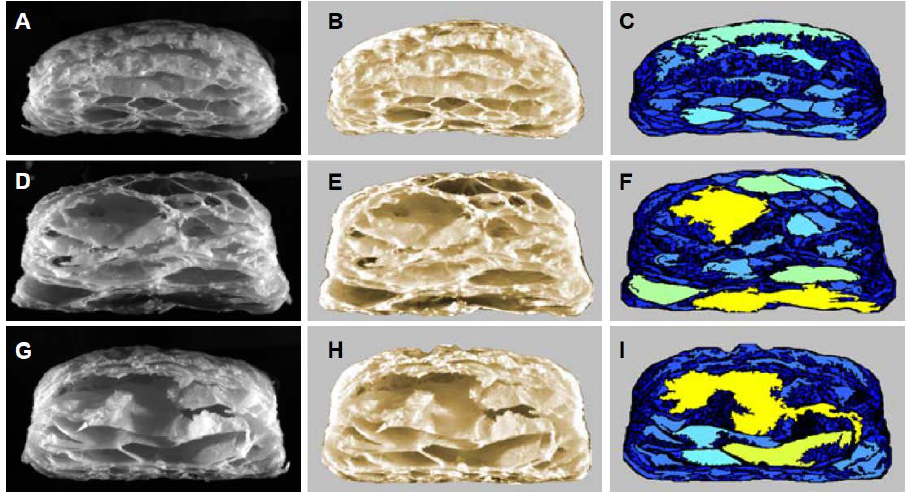
Figure 3. C-Cell images from cross sections of baked puff pastry with 40% fat reduction, 48 layers, 2.00 mm (first row), 0% fat reduction, 81 layers, 2.50 mm (second row) and 0% fat reduction 144 layers, 2.50 mm (third row), raw images ( A , D , G ), brightness image ( B , E , H ) and cell image ( C , F , I ).